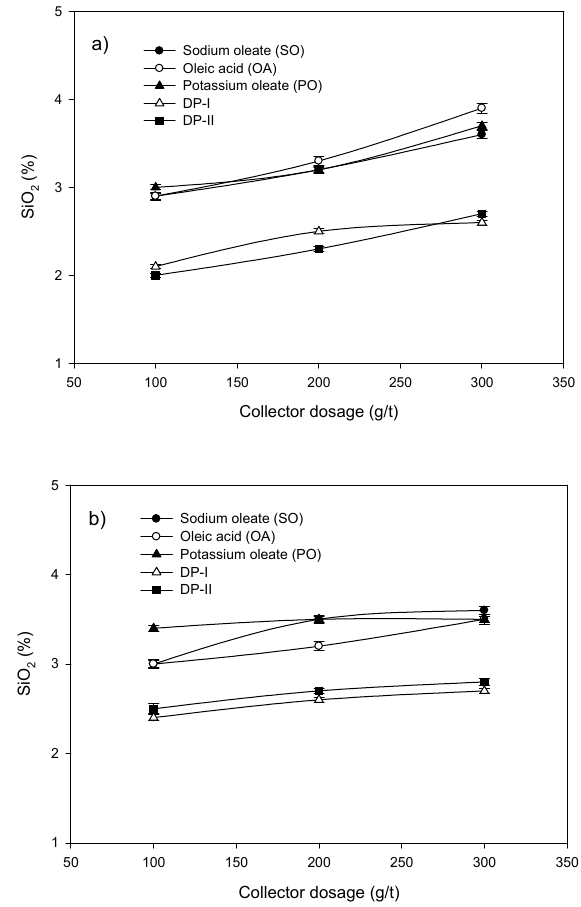
Figure 7. Effect of the collector dosage on the silica grade in the mechanical cell ( a ) and pneumatic cell ( b ) froth flotation.